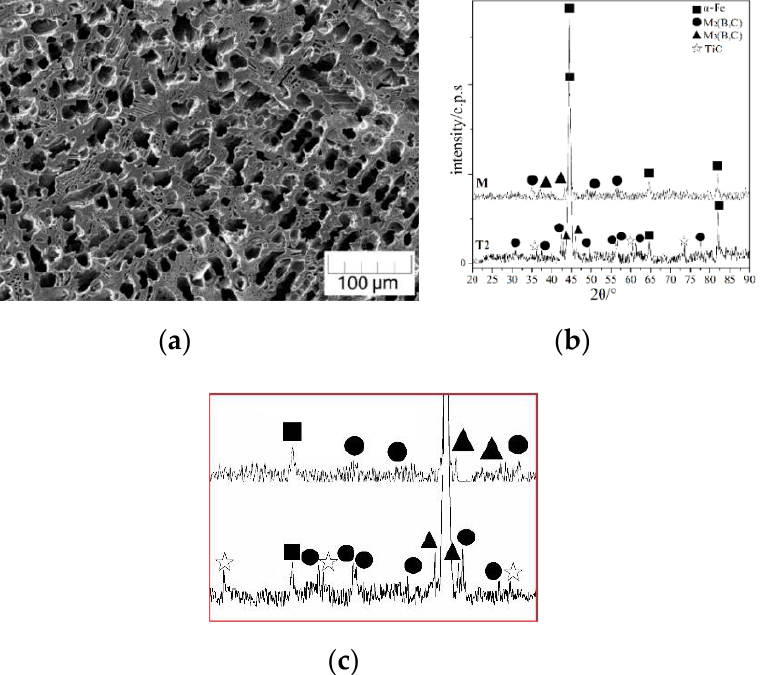
Figure 4. Morphology deep-etched as-cast alloy M ( a ), X-ray diffraction (XRD) patterns of deep-etched alloy T2 and M ( b ) and part details of XRD patterns ( c ).